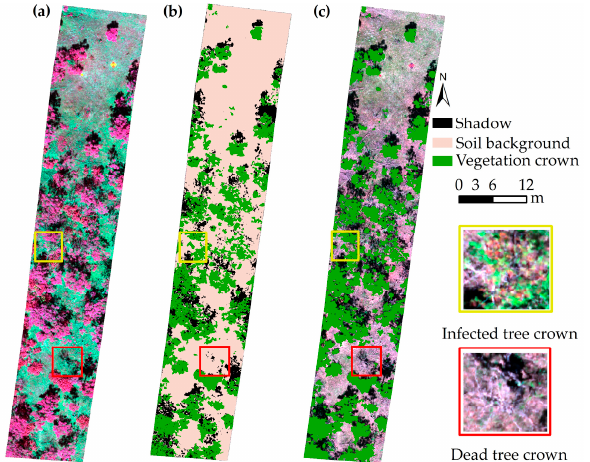
Figure 2. Image segmentation results: ( a ) the original hyperspectral imaging (HI) (false color composition); ( b ) the segmentation of the crowns, soil and shadows; and ( c ) the segmented sunlit crowns.